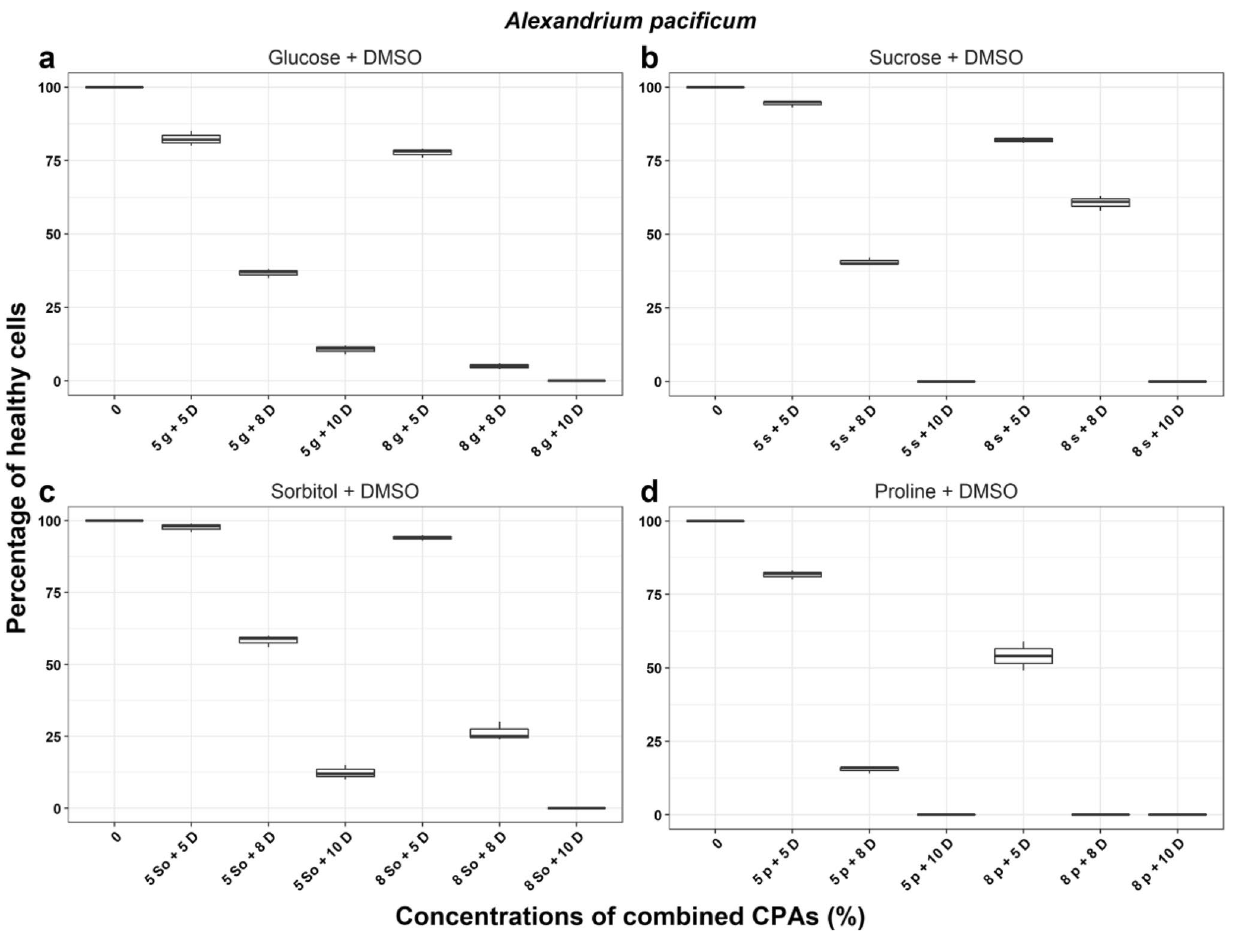
Figure 2. The percentage of healthy Alexandrium pacificum cells after treatment with combined cryoprotectant agents (CPAs) after one week incubation. g Glucose, s Sucrose, D Dimethyl sulfoxide, So Sorbitol, p Proline.